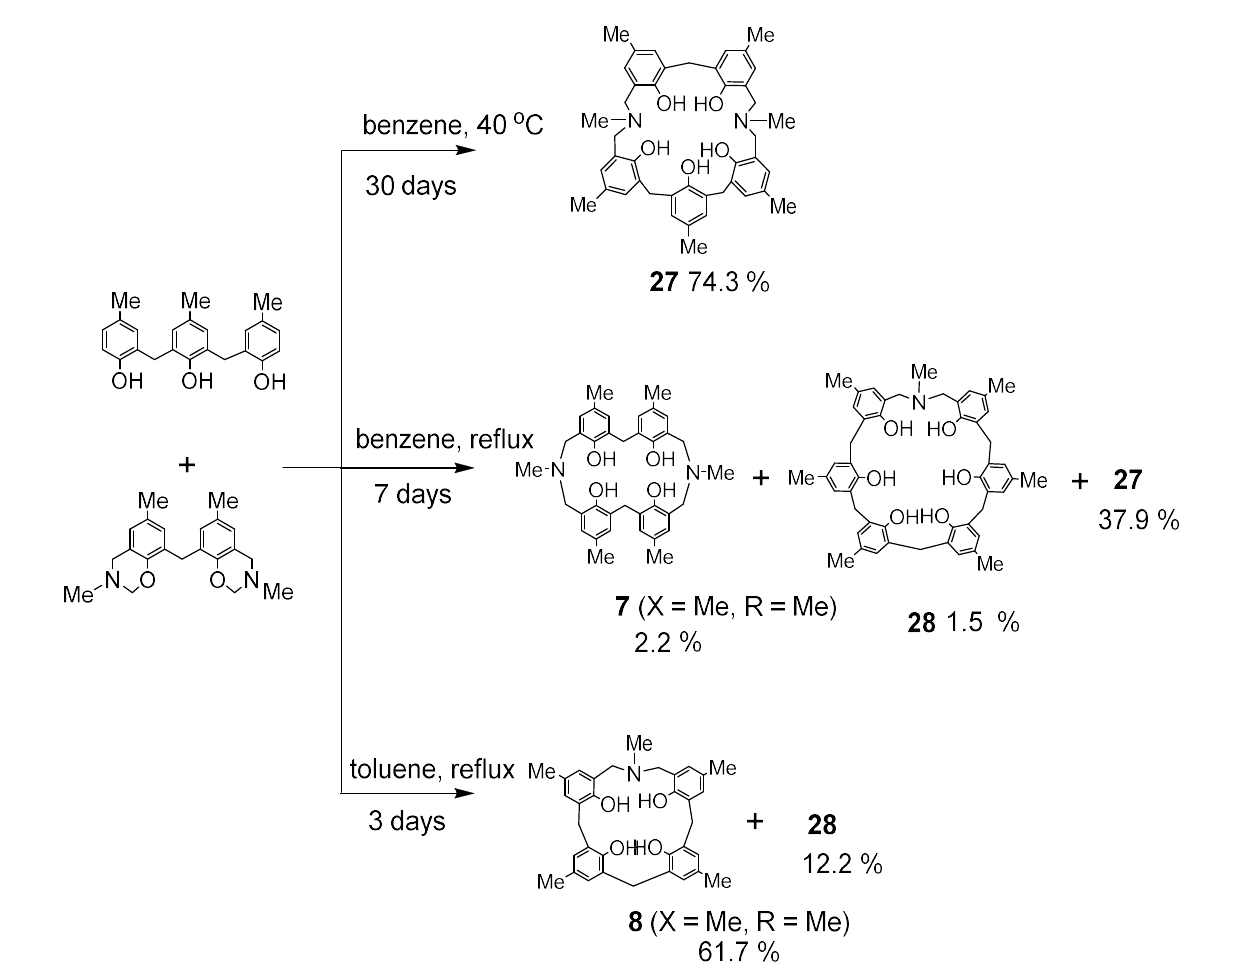
Scheme 12. Products of reaction between phenol trimer and benzoxazine 26a .